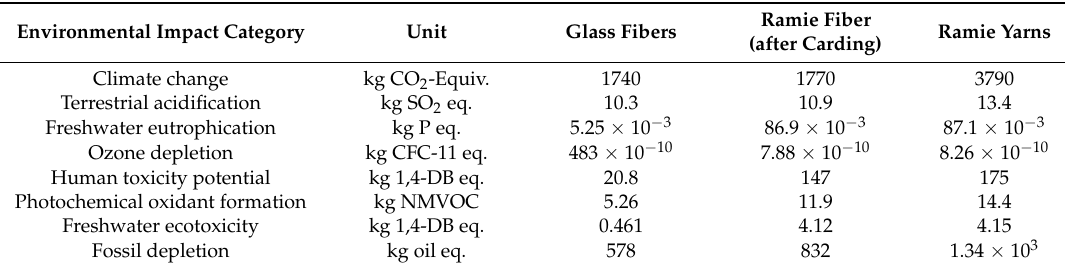
Table 5. Life cycle impact assessment (LCIA) results of one ton ramie yarns, ramie fiber (after carding), and glass